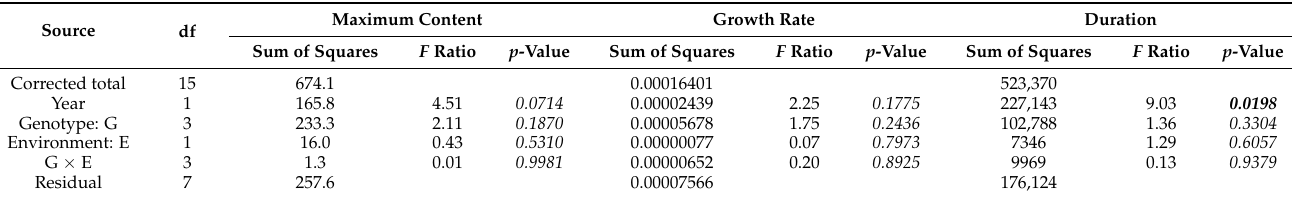
Table 3. Analyses of Variance for the Estimates of Arabinoxylan Content (mg/g) Deposition Parameters: Maximum Content, Growth Rate and Duration.